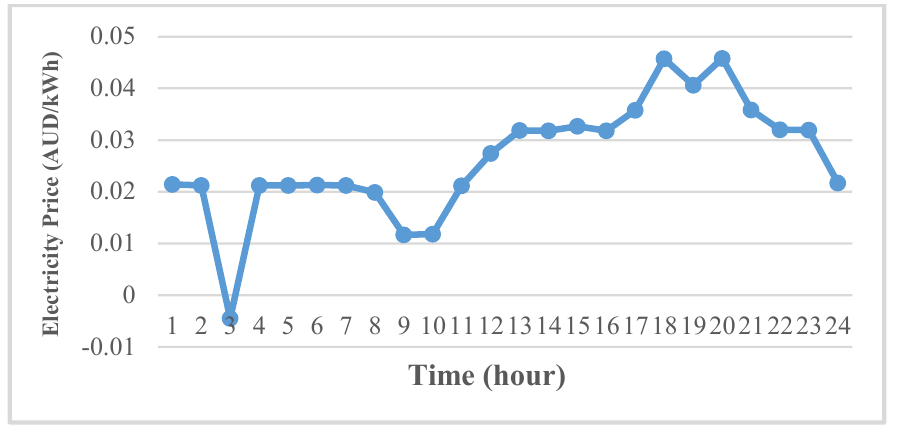
Figure 8. The wholesale market electricity price.